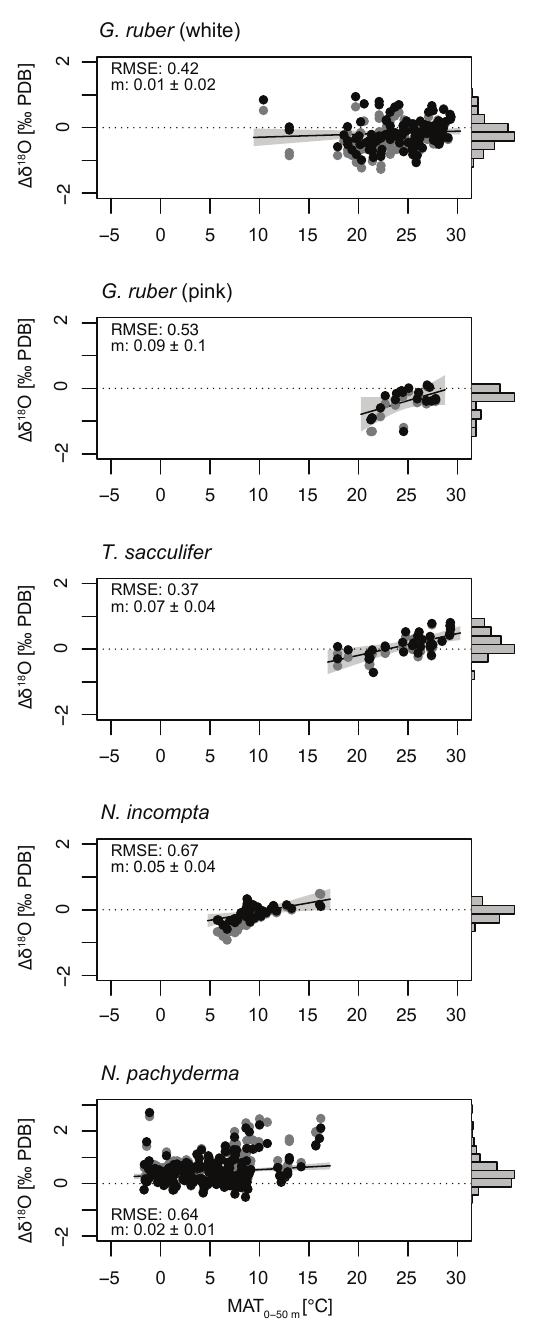
Figure 4. Offset between flux-weighted δ 18 O predicted using the seasonality model depicted in Fig. 3 and observed δ 18 O ( (cid:49)δ 18 O season ). Grey symbols represent (cid:49)δ 18 O annual . mean (Fig. 2). Note the general reduction in the spread of the data (RMSE) and slopes of the (cid:49)δ 18 O season –temperature relationship ( m ) approach- ing 0, compared to (cid:49)δ 18 O annual . mean (Fig. 2), suggesting that sea- sonal habitat tracking partly explains the trends shown in Fig. 2. Error envelopes as in Fig.